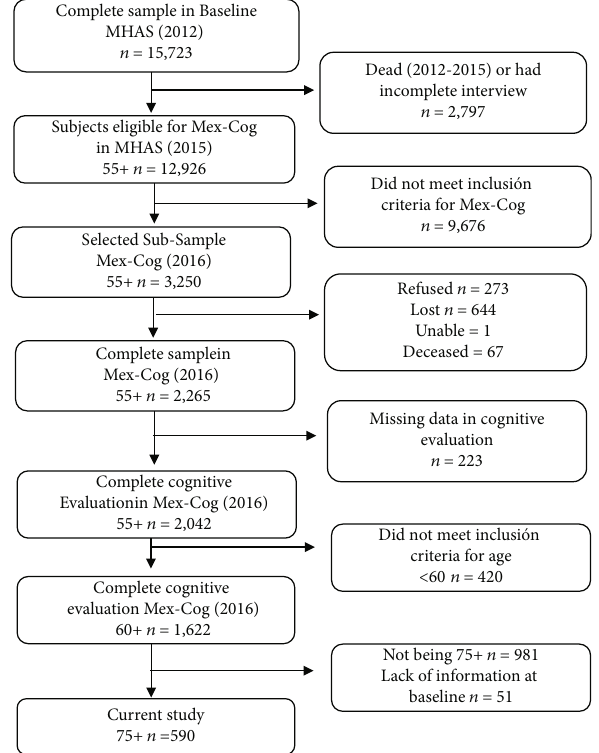
Figure 1: Flow chart of study